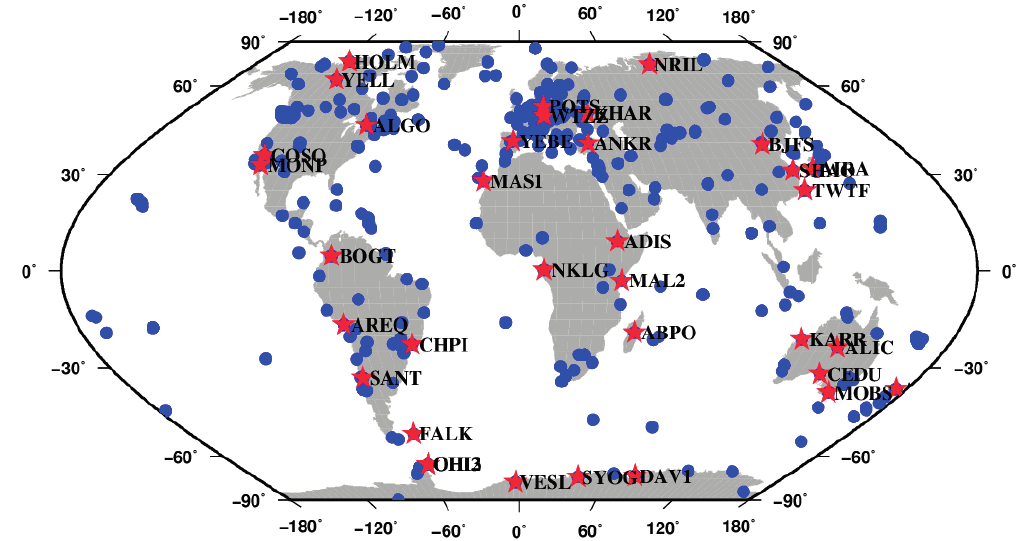
Figure 2. Distribution of the global reference network and user stations. The blue dots are the reference stations used for UPDs estimation; the red stars are the user stations in the test. This figure is created with the GMT software by Wessel and Smith